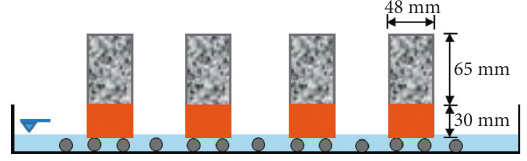
Figure 7: Schematic drawing of sorptivity